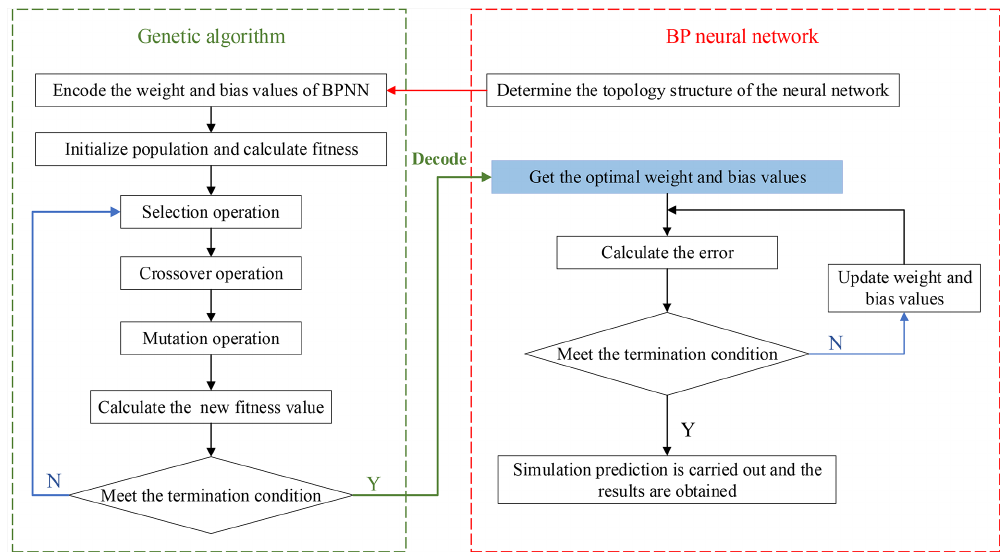
Figure 6. The flowchart of optimized BPNN based on the genetic algorithm.